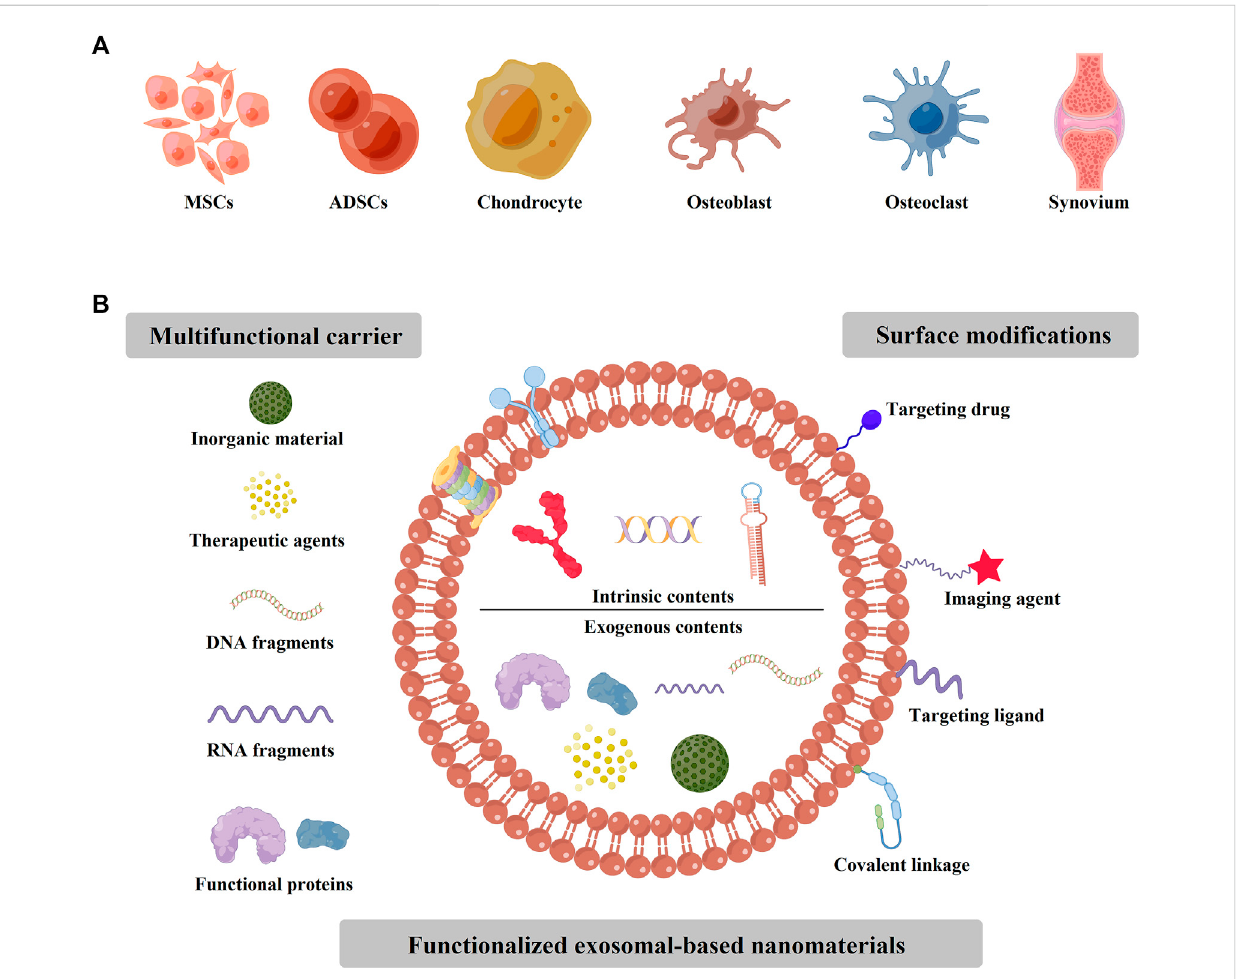
FIGURE 1 The sources of exosomes for the applications of bone/cartilage tissue engineering. (A) The cells or tissues sources of exosomes applied for bone/ cartilagetissueengineering,whichincludeMSCs,ADSCs,chondrocyte,osteoblast,osteoclast,andsynovium. (B) Theintrinsicandexogenouscontentsof various functionalized exosomal-based nanomaterials. For some materials, the exosomes were applied as the multifunctional carriers, such as inorganic material, drugs, DNA or RNA fragments, and some functional proteins. Moreover, some surface modi fi cations could be loaded onto the exosome membrane, such as imaging or targeting